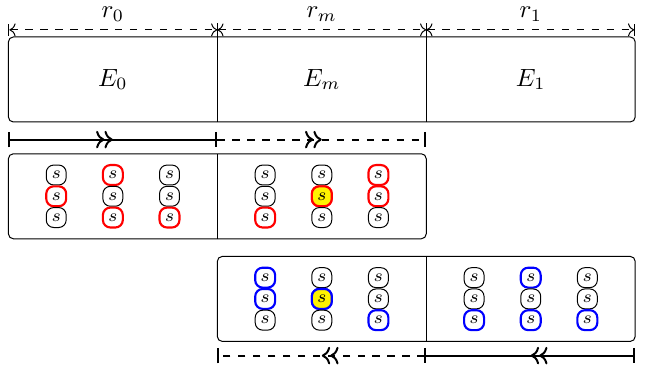
Figure 3: High-level view of common active S-boxes in the boomerang switch. Next, we encode the common active S-boxes between the upper and lower differential trails in the middle part. We define additional variables to indicate whether a certain S-box is active in both upper and lower truncated trails and use them to link the two MILP models. Let u 0 , . . . , u t − 1 denote the activity of S-boxes in the last r m rounds of E m ◦ E 0 , and l 0 , . . . , l t − 1 those in the first r m rounds of E 1 ◦ E m , as depicted in Figure 4. Consequently, u i and l i correspond to the same S-box positions in the middle part for all 0 ≤ i ≤ t − 1. We denote the corresponding t new binary